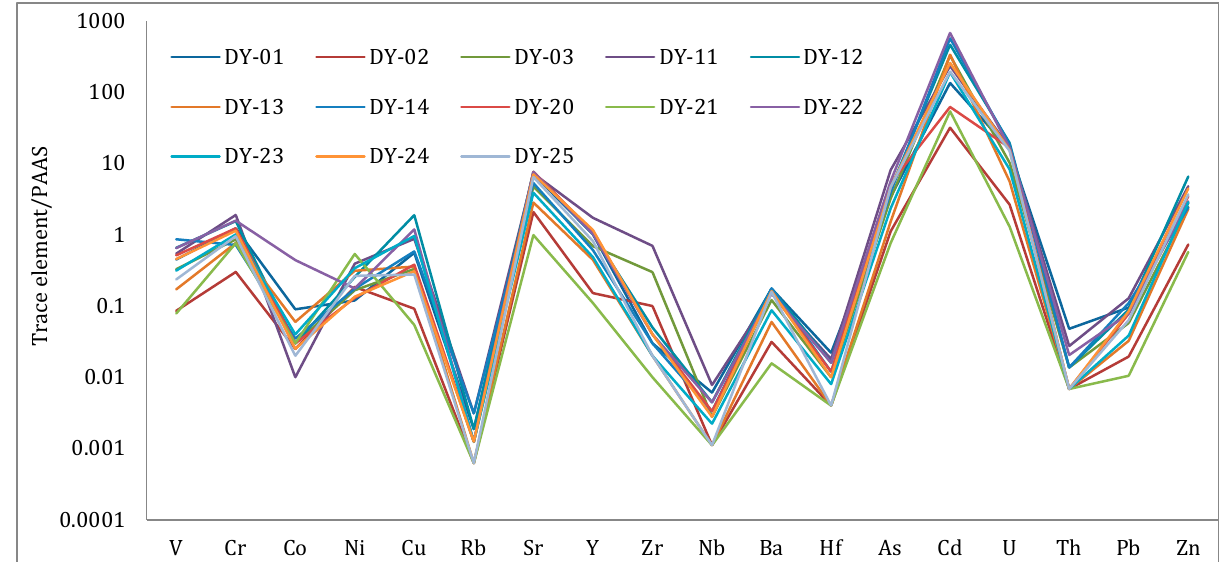
Figure 6. PAAS (Post Archean Australian Shale) normalized according to Taylor and McLennan [59] trace element pattern of the phosphate samples. Table 3. Trace element concentrations (ppm) of the phosphate samples.